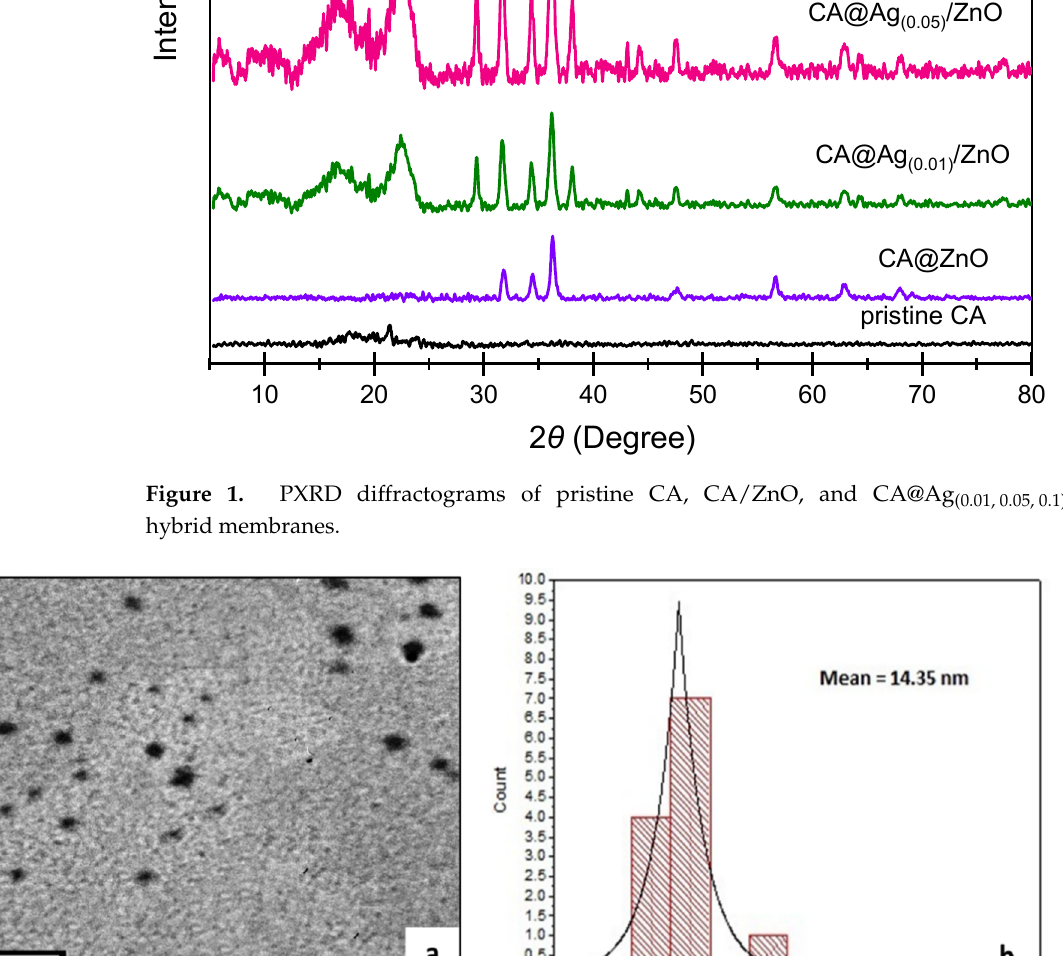
Figure 2. TEM image of CA@Ag (0.1) /ZnO hybrid membrane ( a ) and a histogram of its particle size distribution ( b ).